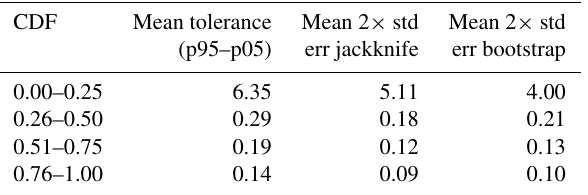
Table 3. Sample uncertainty analysis results per quarter of the to- tal percentage of the modified KGE cumulative distribution func- tion (CDF) of the evaluation period. The mean of the three model instances’ results is calculated based on the tolerance interval, jack- knife standard error, and the bootstrap standard error, for each quar- ter of the total